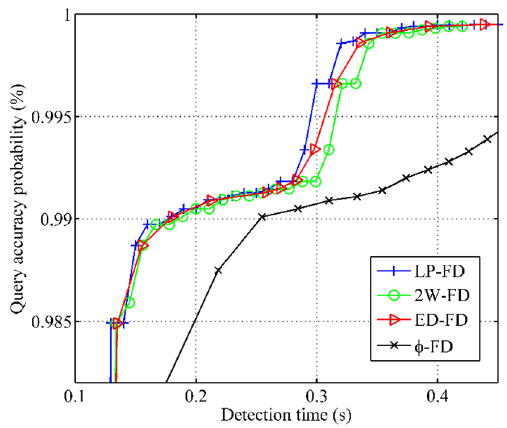
Figure 6. Query accuracy probability vs. detection time.